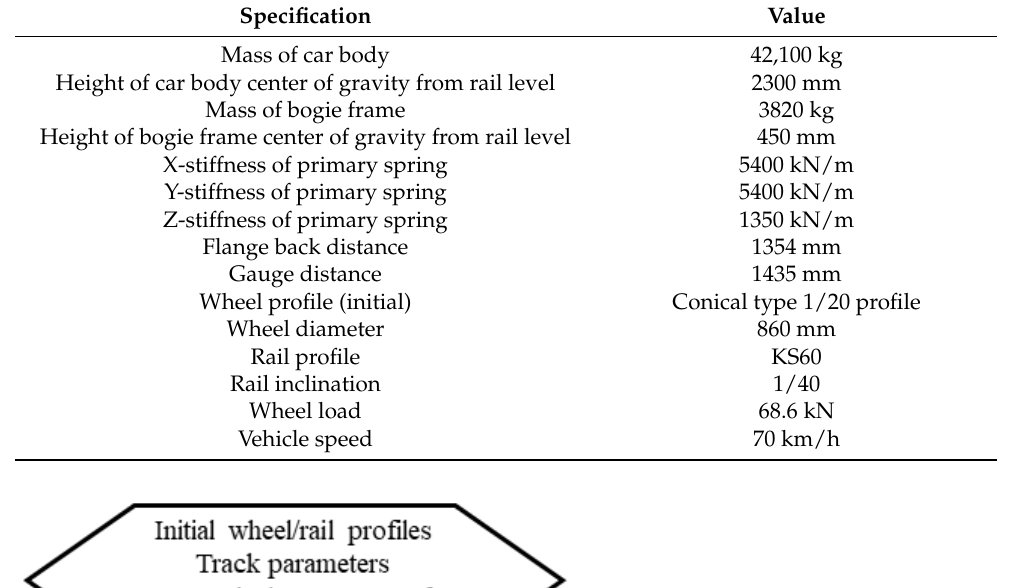
Figure 4. Design variables of wheel profile.